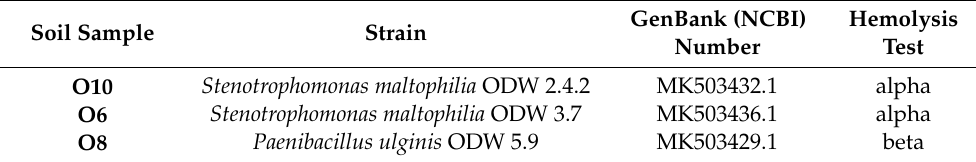
Table 1. Bacteria strains isolated from the creosote-contaminated soil